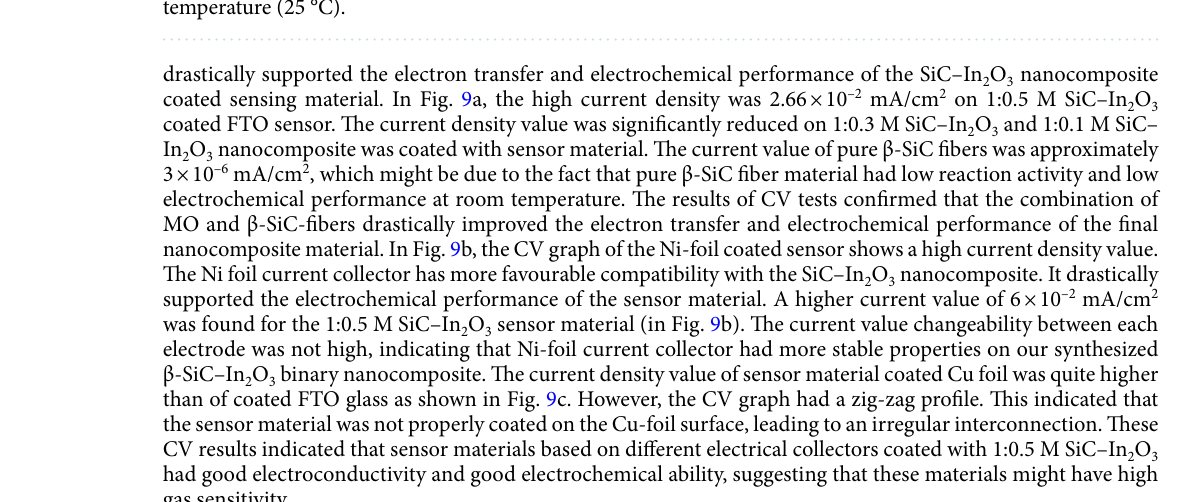
Figure 10. CV test of the as-prepared electrode under CO 2 and O 2 gas-purging conditions at normal room temperature (25